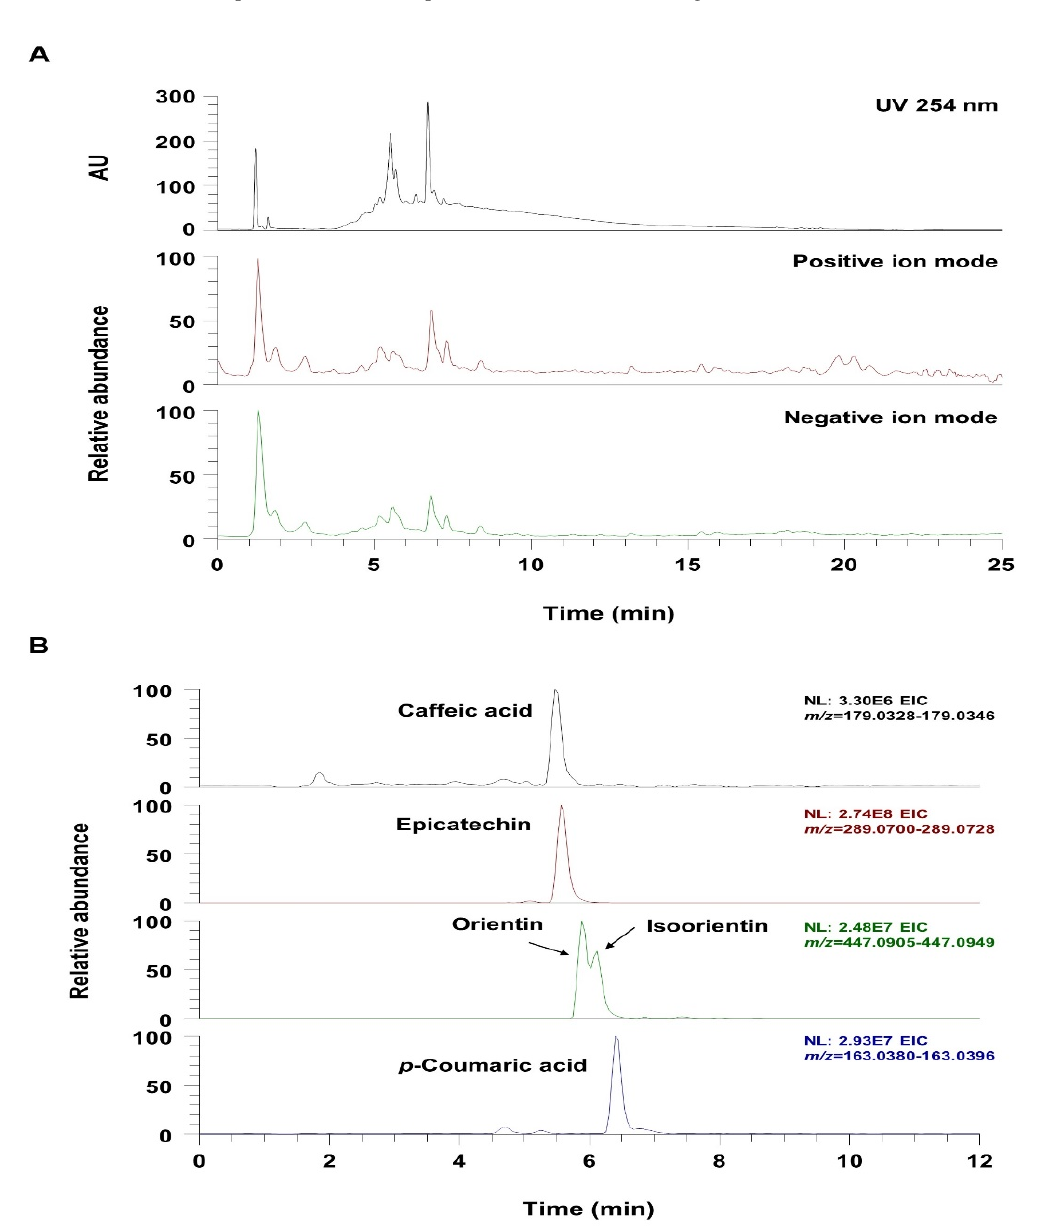
Figure 7. UHPLC UV HRMS analysis of V. bracteatum . ( A ) UV chromatogram and total ion chro- matogram (TIC) of V. bracteatum , ( B ) Extracted ion chromatogram (EIC) of the identified phytochemi- cals in V. bracteatum in the negative ion